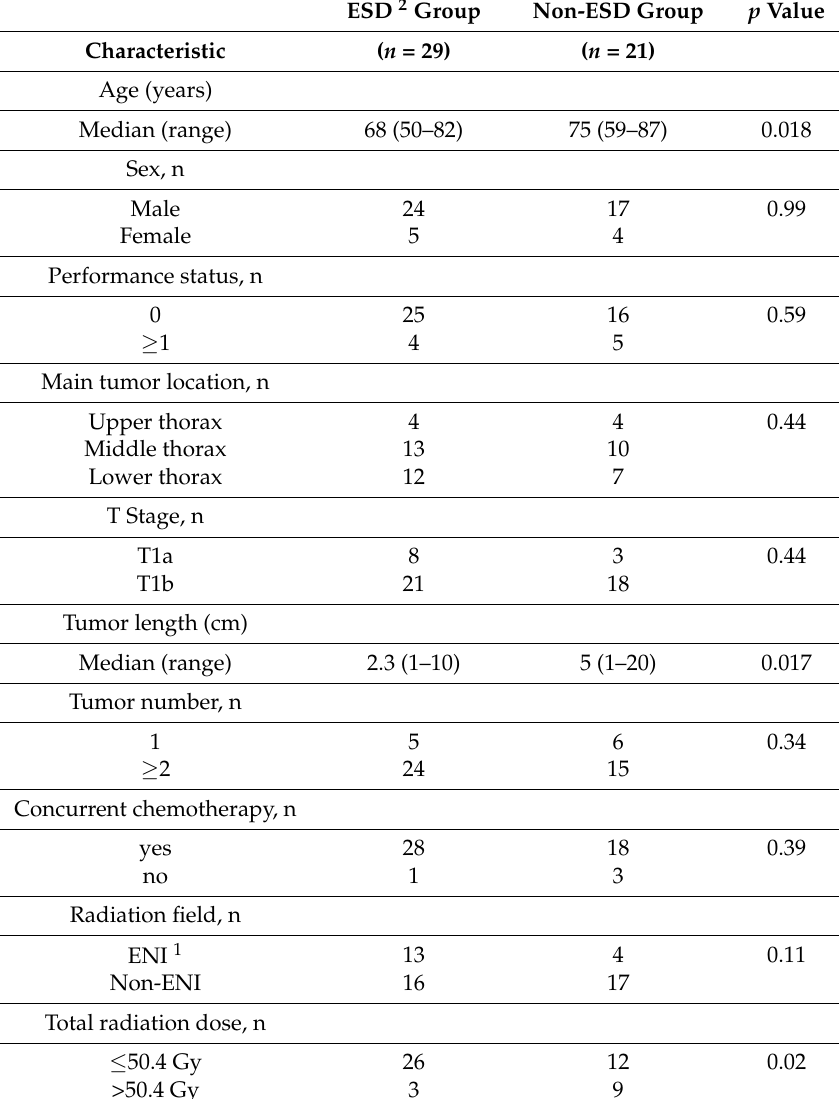
Table 1. The patient and tumor